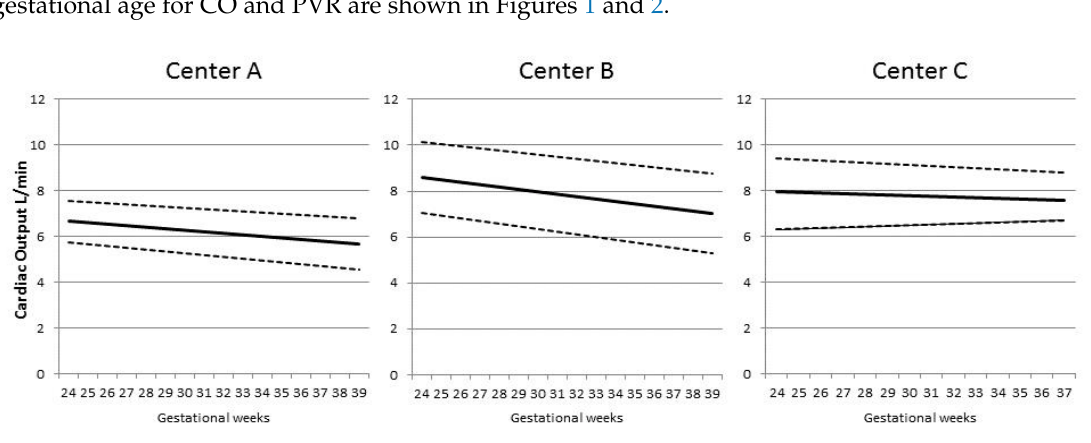
Figure 1. The figure shows the trend of maternal cardiac output in relation to gestational week for Centre A, B and C, respectively. Differences in trends represent the different proportion of controls and cases with preeclampsia, small for gestational age/fetal growth restriction or both in the three centres. Mean ± 1 SD (L/min).